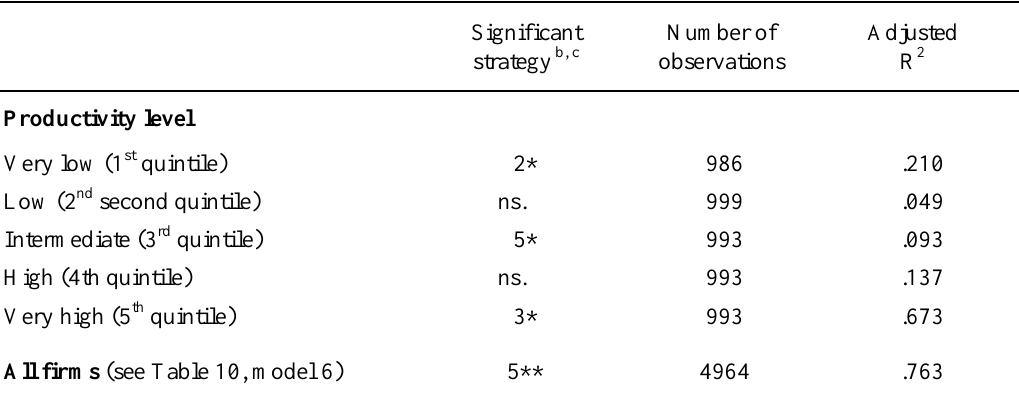
Table 11 : Relationship between innovation strategies a and labour productivity (log): Differentiation by (Pooled data 1999, 2002, 2005 and 2008; OLS estimation of model 6 shown in Table 10)